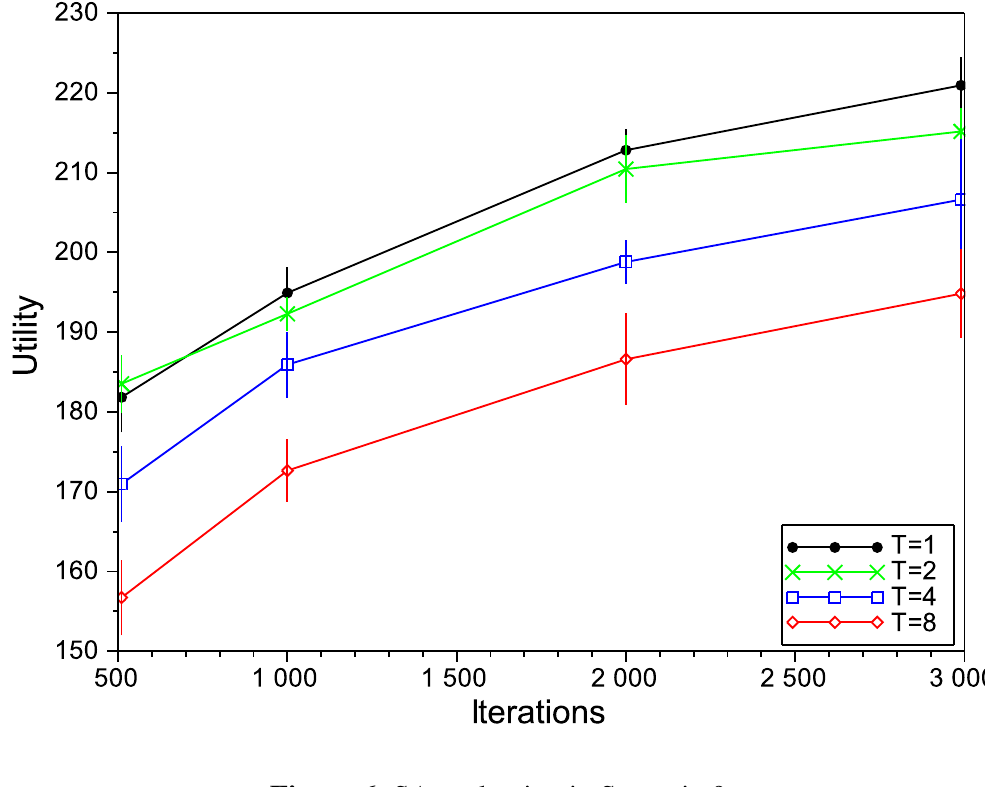
Figure 6. SA evaluation in Scenario